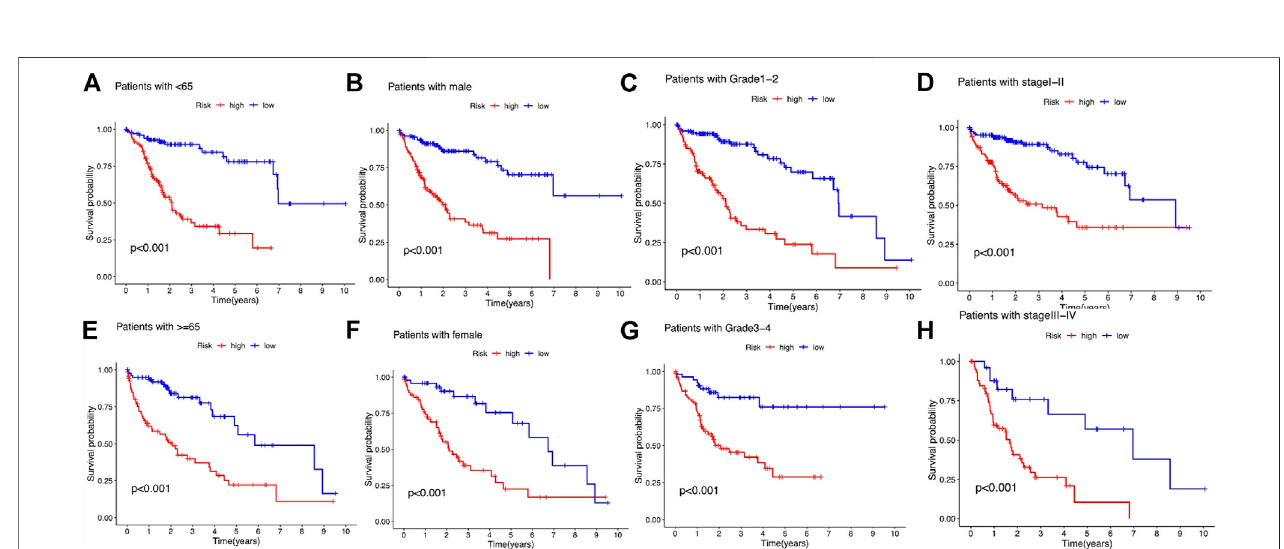
FIGURE 6 | Kaplan – Meier survival analysis strati fi ed by age, gender, tumor grade, and stage between the high- and low-risk groups in the entire set. (A) Patients with age < 65. (B) Patients with male gender. (C) Patients with tumor grade 1-2. (D) Patients with tumor stage Ⅰ – Ⅱ . (E) Patients with age ≥ 65. (F) Patients with female gender. (G) Patients with tumor grade 3-4. (H) Patients with tumor stage Ⅲ – Ⅳ .